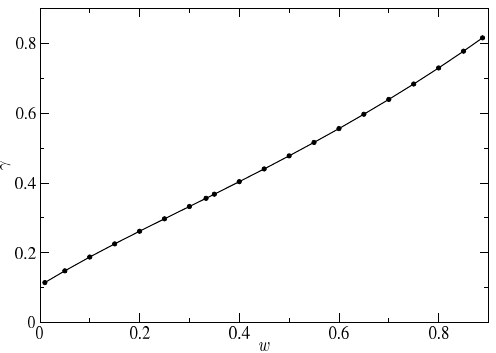
Figure 3. Values of γ ( w ) plotted from the data of Table 1 in